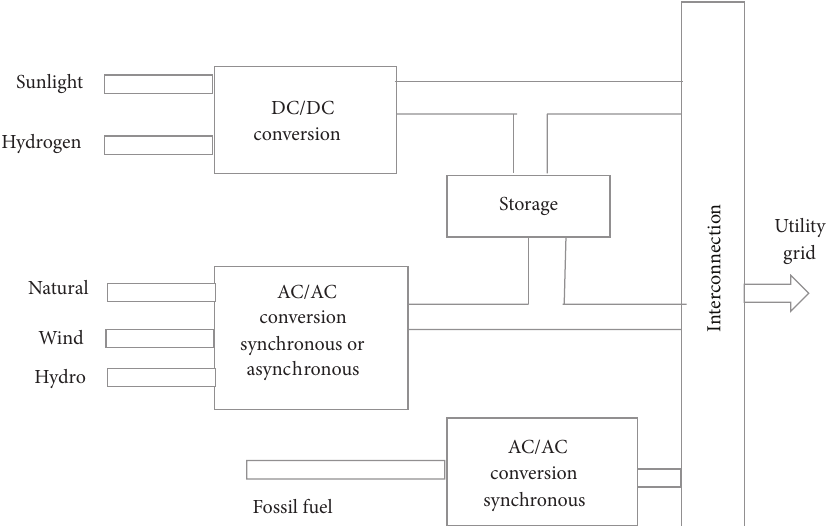
Figure 12: Integration of several sources of energy into the